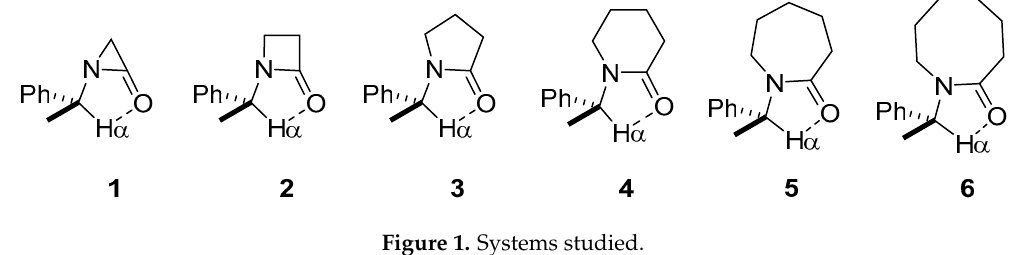
Figure 1. Systems studied.